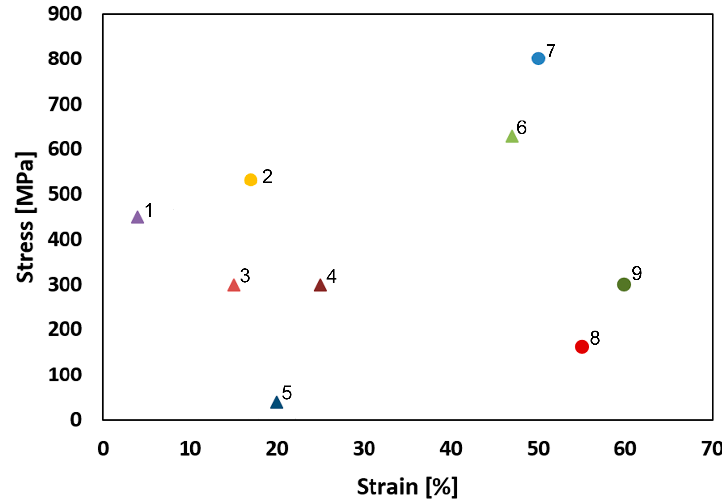
Figure 8. Comparison of the aquired results of the mechanical properties (UTS values) with UTS values of the 3D-printed and deformation-processed AISI 316L steel presented in the available literature. Legend to the individual points: 1—high laser power sample by Montero-Sistiaga et al. [39];